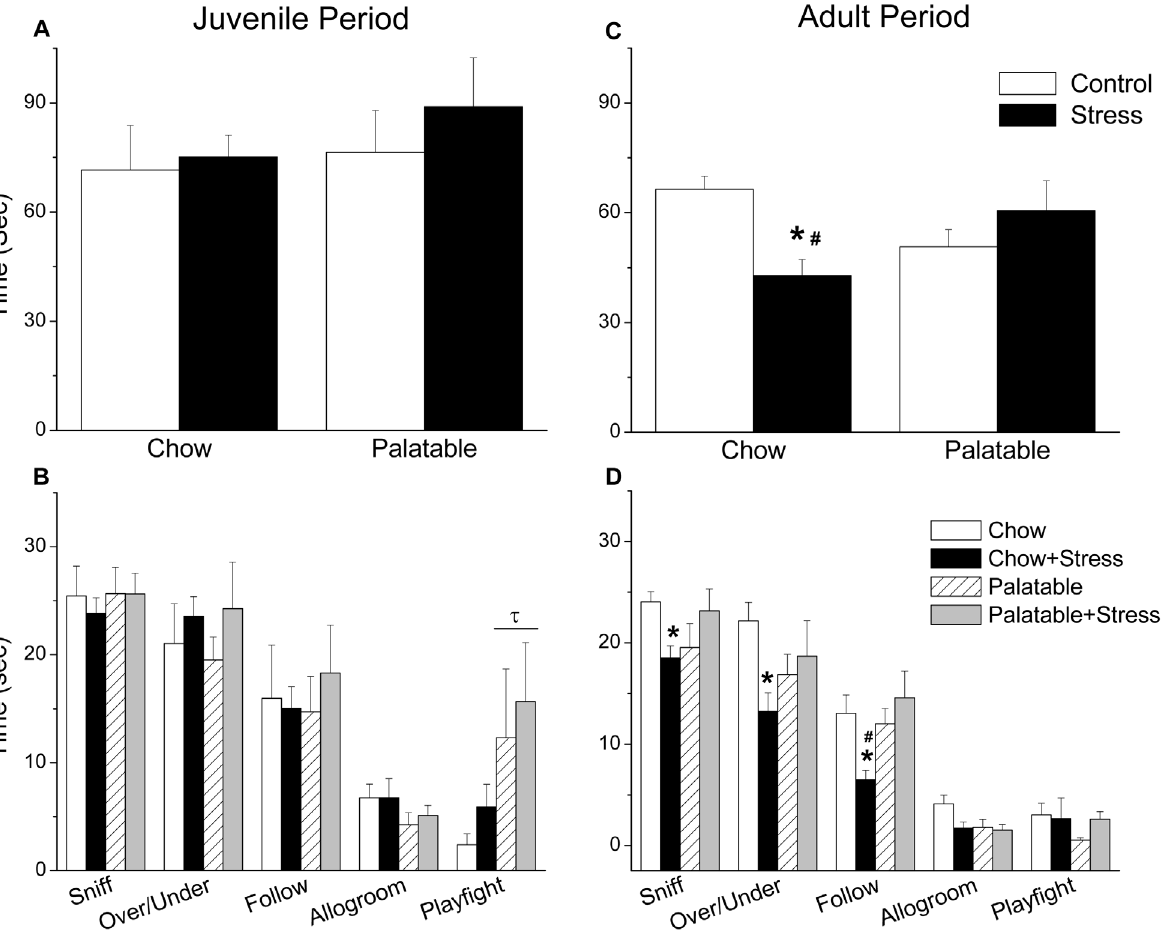
Figure 4. Social behavior in the social interaction test. No significant differences in total time engaged in social behaviors were observed in the juvenile phase (A); however, in general rats with access to the palatable diet engaged in more play fighting (B). In adulthood, previously stressed chow fed rats spent less total time engaged in social behaviors compared to chow-fed controls and previously stressed rats with access to the palatable diet (C). In regards to specific behaviors, chow fed rats exposed to the juvenile stress spent less time sniffing, following and moving over/ under one another (D) relative to their controls. The difference between stress groups was significant for following behavior as well (D). Bars represent mean 6 SEM. t Significant diet effect. * Significantly different from controls. # Significantly different from condition matched rats receiving opposite diet.